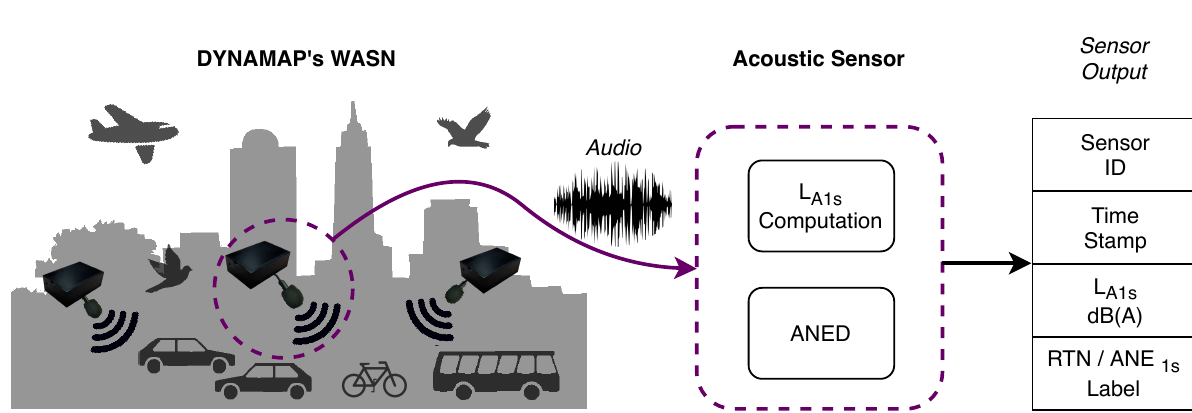
Figure 1: Block diagram of the DYNAMAP’s WASN, describing the main processes run in the low-cost acoustic sensors every second, includ- ing the computation of the A-weighted equivalent noise level ( L ) and the Anomalous Noise Event Detector (ANED), which labels the input A 1 s acoustic data as Road Traflc Noise (RTN) or Anomalous Noise Event (ANE) every second. Moreover, the sensor sends its identifier (ID) and the time stamp to the central